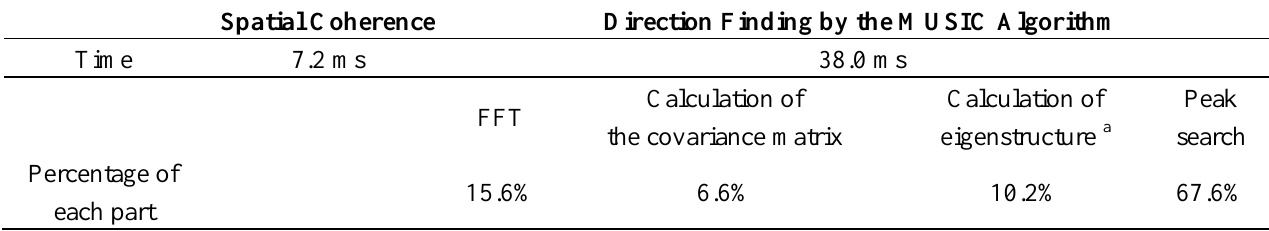
Table 2. Computational complexity of the proposed